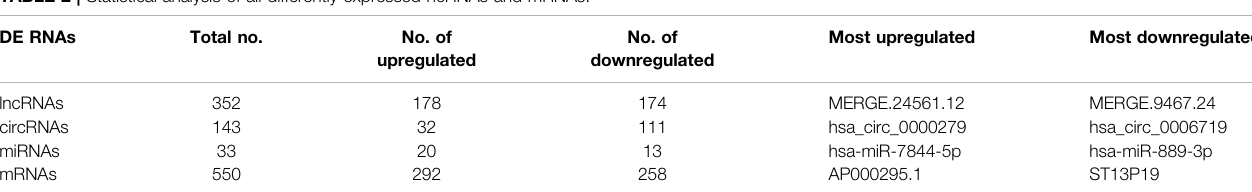
MERGE, novel lncRNA, an assembled